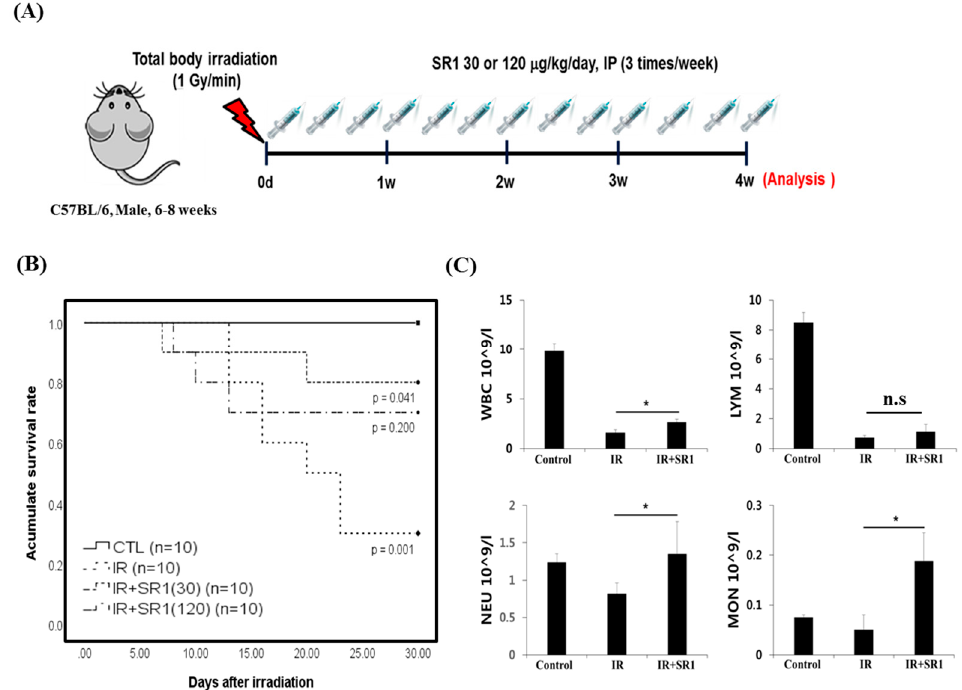
Figure 1. Effect of StemReginin 1 (SR1) on TBI-induced lethality and pancytopenia in mice. ( A ) Schematic of radiation and SR1 treatment for mice. Male C57BL/6 mice (n = 10) were irradiated using a single exposure of 6 Gy of TBI, and either 30 or 120 µg/kg of SR1 was administered by in- traperitoneal injection as the indicated treatment (three times per week) after irradiation. ( B ) Kaplan–Meier survival curve depicts the 30-day survival for saline-treated mice (control), irradi- ated (IR) mice, and mice treated with irradiation with different doses of SR1 (IR+SR1). ( C ) Periph- eral leukocyte counts by total differential blood cell counts (WBCs, neutrophils (NEU), lympho- cytes (LYM), and monocytes (MOM)) in irradiated mice with or without 30 µg/kg of SR1 treatment. The data are shown as means ± SE (n = 6 per control group, n = 3 per IR group, and n = 6 per IR+SR1 group); * p < 0.05 versus irradiated group; n.s: not significant; TBI: total body irradiation.